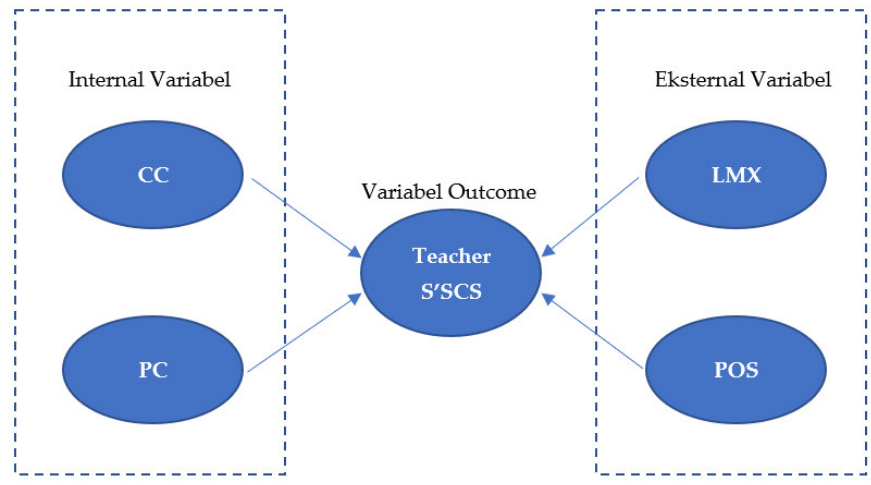
Figure 1. Description: career commitment (CC); professional commitment (PC); leader–member exchange (LMX); perceived organizational support (POS).